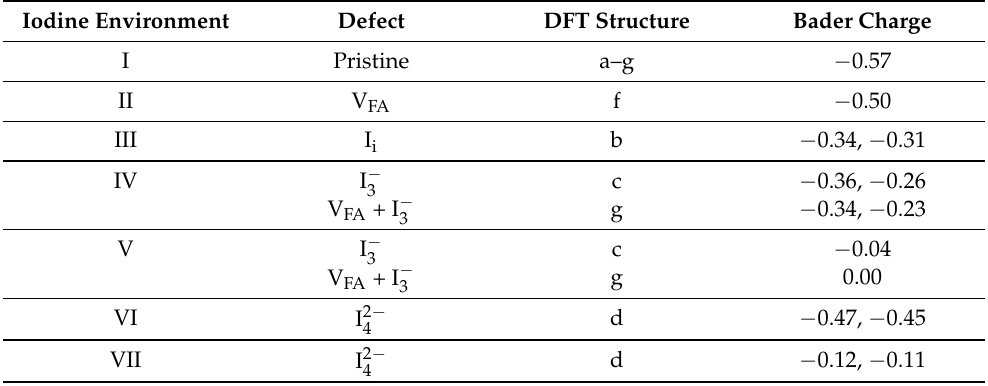
Figure 2. Chemical environments of iodine in defect structures. ( I ) Iodine branching two corner- sharing octahedra as in pristine perovskite, ( II ) iodine surrounding V FA , ( III ) iodine dimer, ( IV ) end of iodine trimer, ( V ) middle of iodine trimer, ( VI ) end of iodine tetramer, ( VII ) middle of iodine tetramer. Depth cueing indicates the foreground and background atoms. Table 1. Bader charge for each iodine chemical environment in associated defect